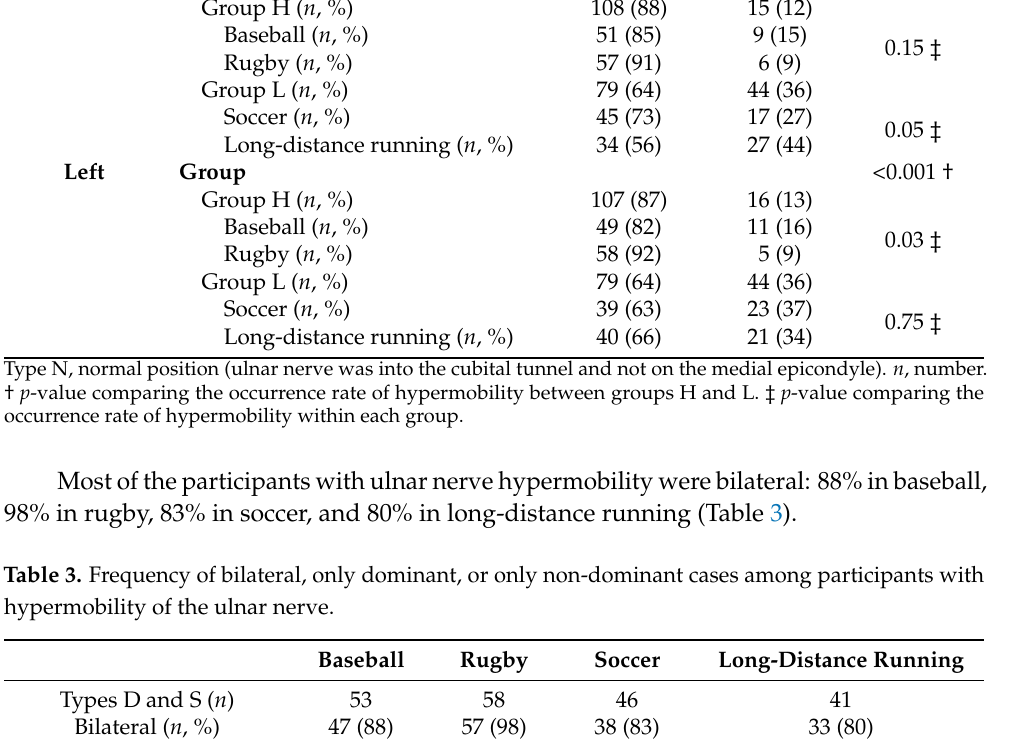
Table 2. Frequency of hypermobility of the ulnar nerve among groups H and L.